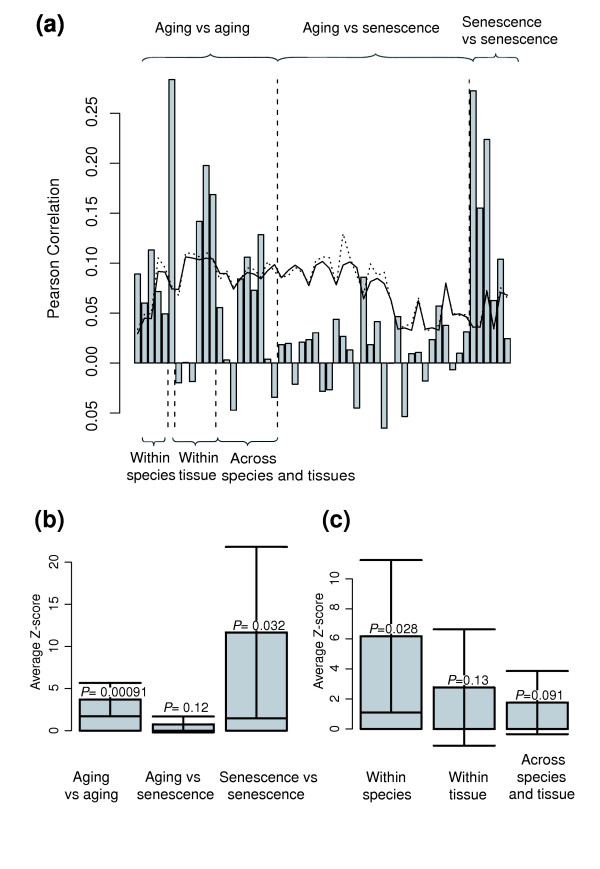
Robust transcriptome signatures of cellular senescence and aging. (a) Fifty-five pair wise comparisons of eleven aging and senescence datasets are divided into groups on the basis of the nature of the comparison: aging versus aging (n = 21), aging versus senescence (n = 28), and senescence versus senescence (n = 6). The aging versus aging group is further divided into within species, within tissue, and across species and tissue groups (the highly correlating aging mouse cerebellum to cortex comparison can not be allocated to any of these groups, as it is 'within species and tissue'). Bars represent the correlation in each comparison. The continuous line represents a threshold for significance corresponding to a Bonferroni corrected P value < 0.005, as determined by the random distributions of correlations. The dotted line represents the maximum correlation in that distribution (10,000 iterations). (b) Analysis of the average Z-score (displacement from the random distribution of correlations in numbers of standard deviations) for the aging versus aging, aging versus senescence, and senescence versus senescence groups. Only the aging versus aging and the senescence versus senescence groups have a mean that passes a t test for being different from zero. (c) Identical analysis of the within species, within tissue, and across species and tissue groups. Only the within species group has a mean that passes a t test for being different from zero. In (b,c), P values and tails represent the P value for having a mean different from zero, and the 95% confidence interval for the mean, respectively.